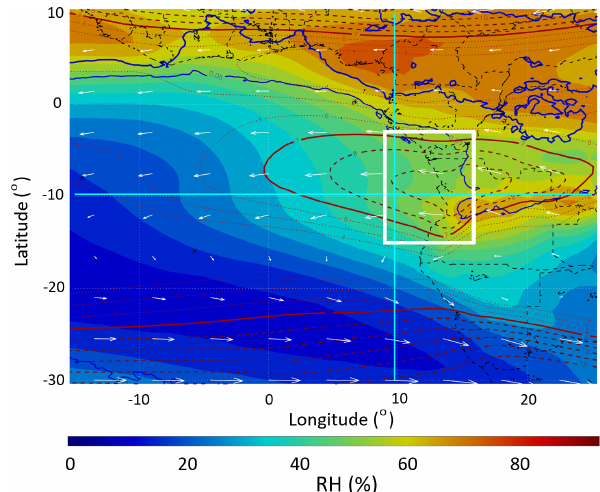
Figure 6. September-mean relative humidity (RH – color fill) and horizontal winds at 4km (averaged over 600–650hPa – red contours and white arrows), and the southerly limit of significant rainfall av- eraged over 19 years (2000–2018 – blue contour). Heavy solid and dashed red contours indicate elevated wind speeds (7ms − 1 – solid; 8 and 9ms − 1 – dashed). The white rectangle encompasses 8–16 ◦ E and 14–3 ◦ S. The cyan lines refer to 9.75 ◦ S and 9.75 ◦ E, respec- tively (see Fig. 7). RH and winds are from the ERA-Interim analy- ses, and the rainfall is from the monthly 0.25 ◦ satellite-based 3B43